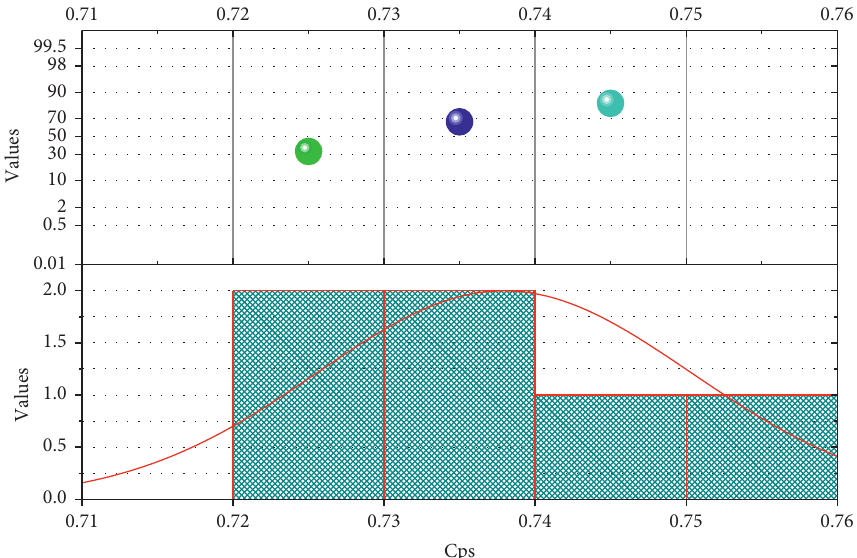
Figure 8: Comparison of average service latency with different task offloading